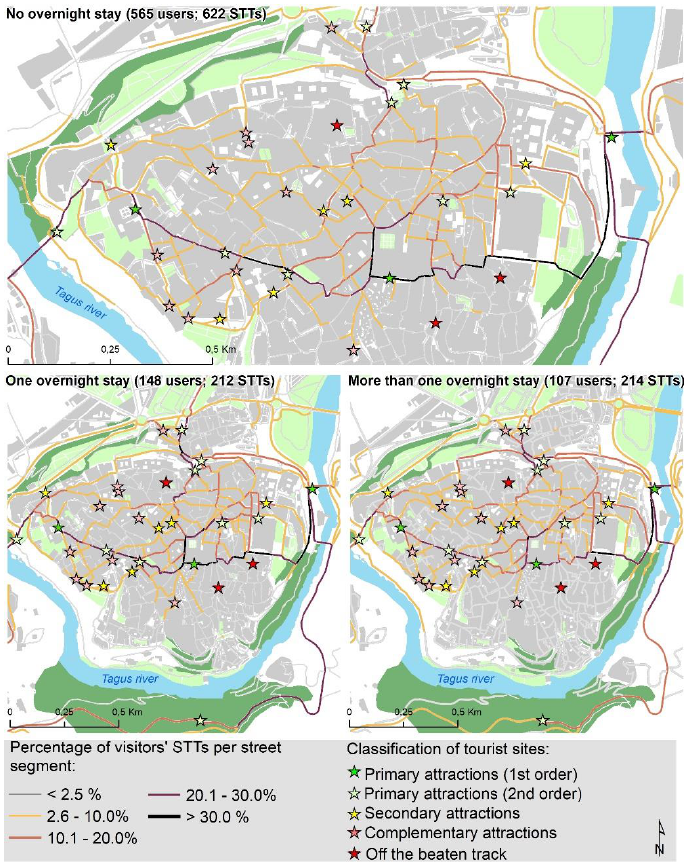
Figure 9. Percentage of visitor STTs per street segment per type of visitor. Source: Authors’ own elaboration.